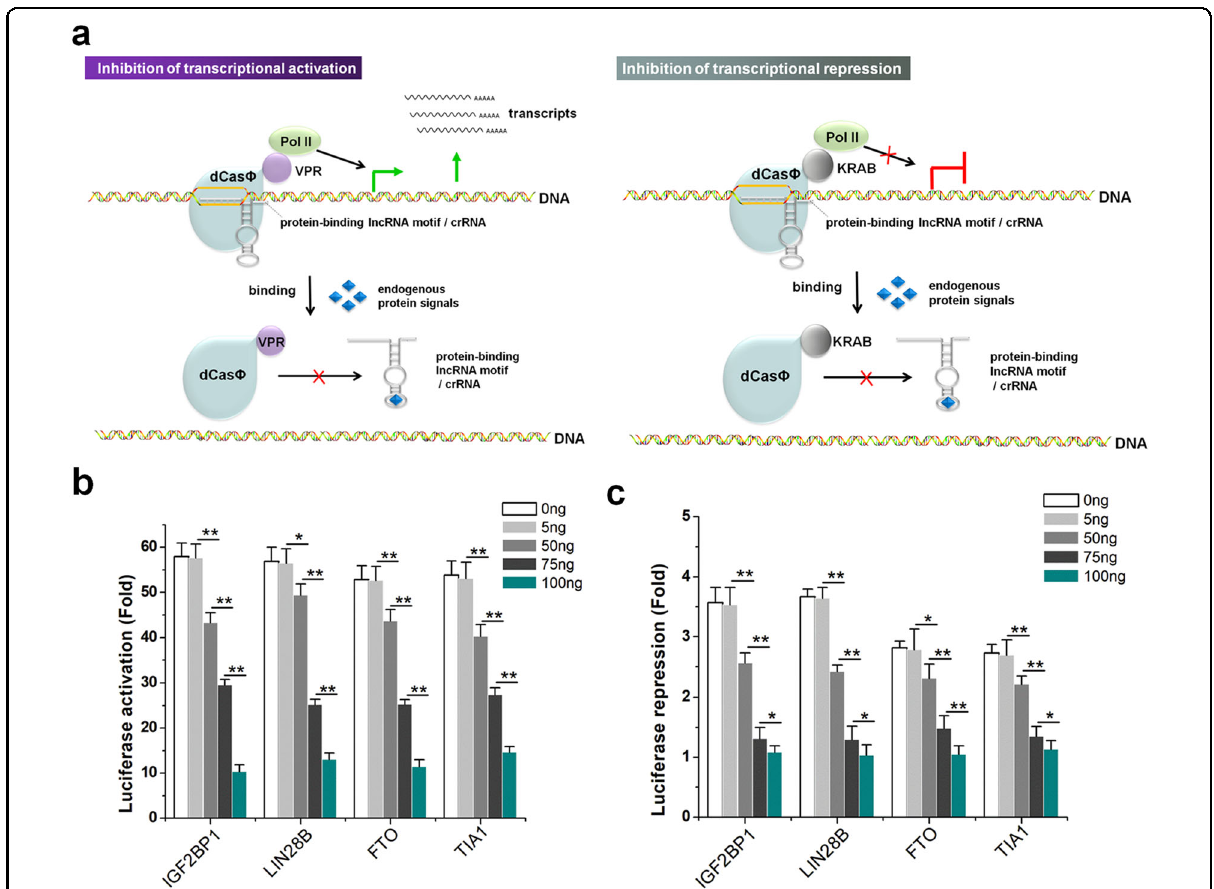
Fig. 5 Inhibition of CRISPR transcriptional activity by endogenous protein signals. a Schematic diagram showing the inhibition of CRISPR transcriptional activity by endogenous protein signals. b The transcriptional regulatory activity of dCas Φ -VPR decreased signi fi cantly with the increase in the amount of transfected overexpression plasmid. c The transcriptional regulatory activity of dCas Φ -KRAB decreased signi fi cantly with increases in the amount of transfected overexpression plasmid. Relative luciferase activities were determined as the ratios of Rluc to Fluc values. The fold change in each group was determined by comparison with the wild-type crRNA negative control. The reported data represent the means ± SD from fi ve independent experiments. * P < 0.05; ** P < 0.01, relative to the control, two-tailed t